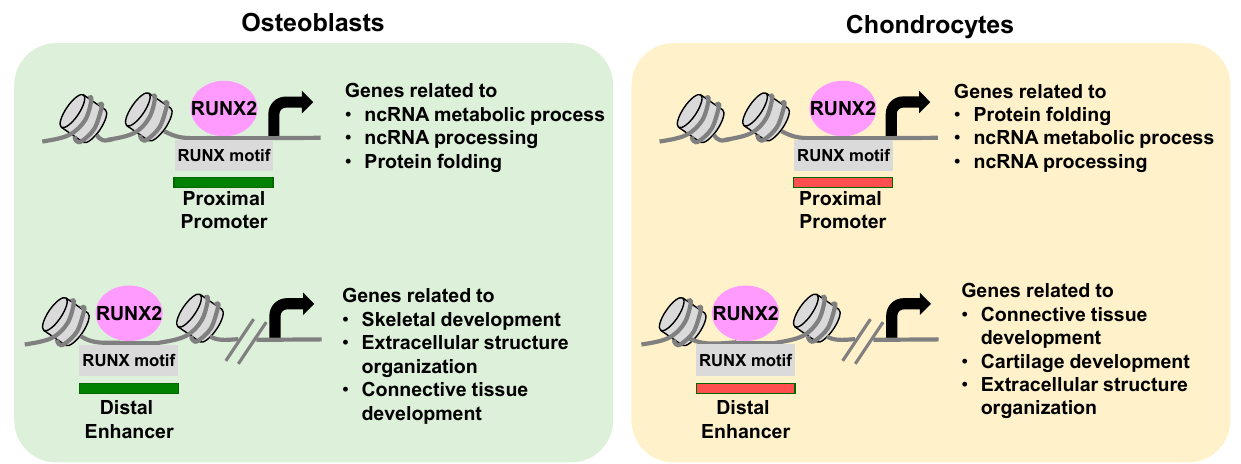
Figure 2. Mode of action of Runx2 in osteoblast and chondrocyte development. Runx2 is associated with TSS regions of genes related to general cell activities; it is also associated with distal cis-regulatory elements targeting distinct cell-type gene sets. Runx2 binding to the consensus motif is the primary mode of action regardless of the distance from TSS. Gene ontology terms enriched by each association modes are shown.